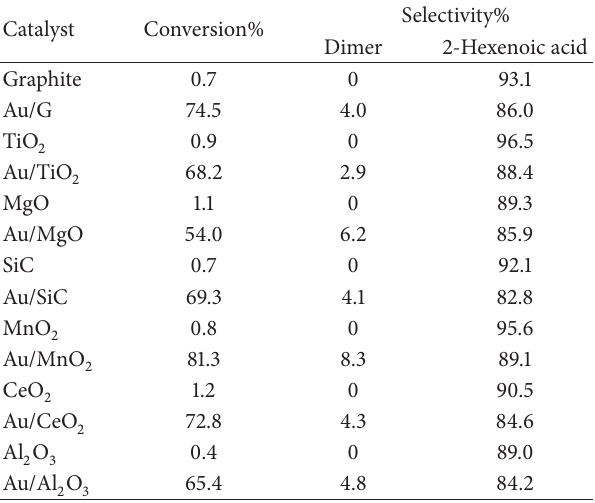
Table 1: Effect of support on 2-hexenal